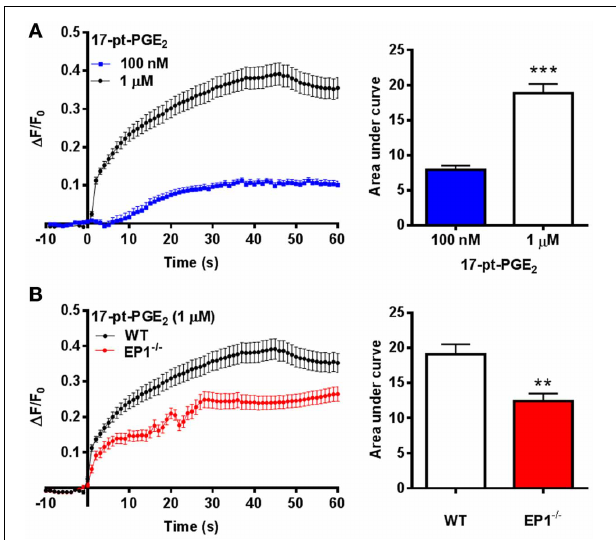
FIGURE 4 | EP1 receptor mediated changes in [Ca 2 + ] i in neurons. (A) (cid:2) F / F 0 values recorded in response to 17-pt-PGE 2 (100nM and 1 μ M) normalized to the fluorescence values recorded before application of 17-pt-PGE 2 and plotted as a function of time. Bar charts represent changes in AUC (arbitrary units) following treatment with 17-pt-PGE 2 . (B) (cid:2) F / F 0 values recorded in response to 17-pt-PGE 2 (1 μ M) in neurons cultured from WT and EP1 − / − pups. Data represent mean ± SEM. Statistical analysis was carried out using unpaired students t -test ∗∗∗ p < 0 . 001 to compare the change in fluorescence intensity between different two groups: 100nM vs. 1 μ M; ∗∗ p < 0 . 01 to compare between genotypes WT vs. EP1 − / − in response to 17-pt-PGE 2 .